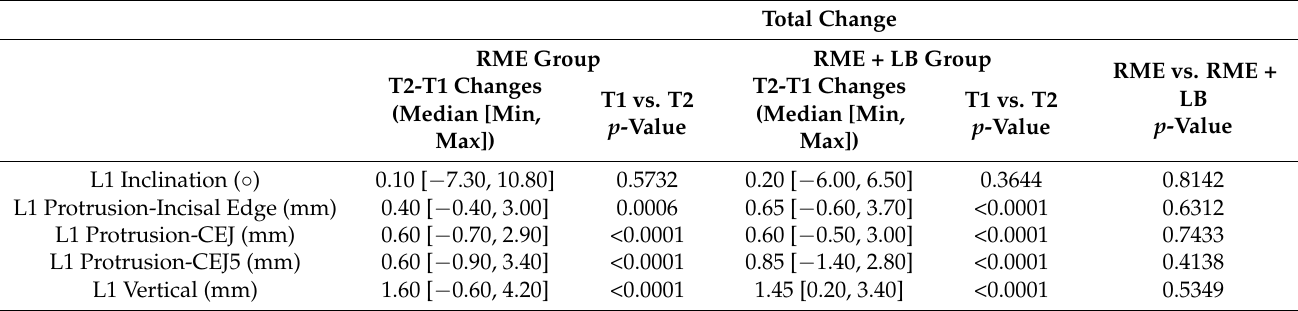
Table 3. The amount of total changes of each measurement parameters for both groups. For T1 vs. T2 comparisons within group, Wilcoxon matched-pairs singed rank test was used. For RME vs. RME + LB comparisons, Mann–Whitney U test was